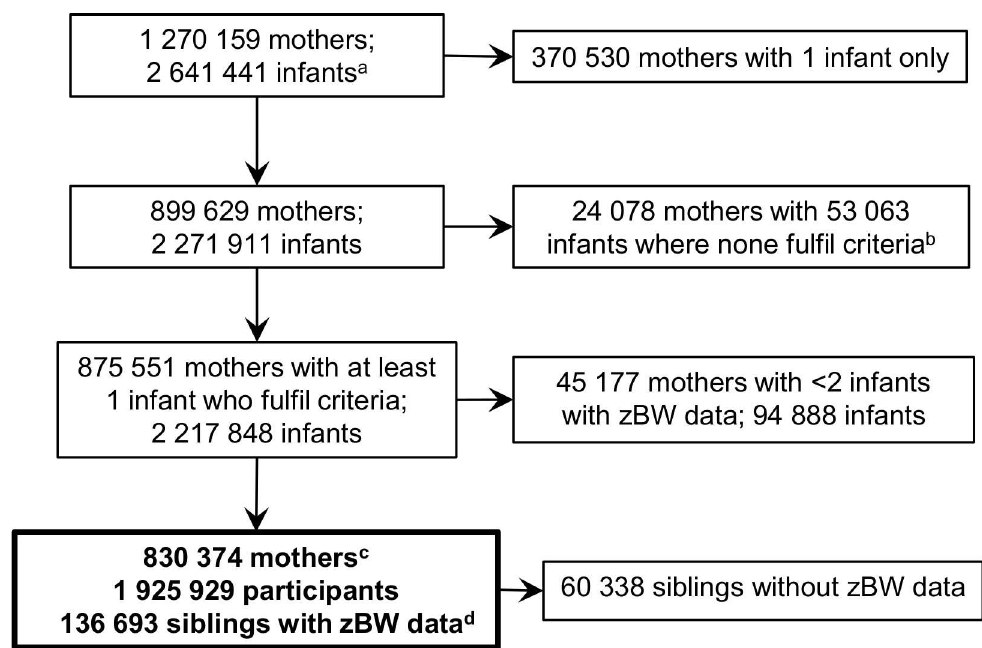
Fig 1. Study population. zBW: z-score birth weight, standardized for year of birth, sex, birth order, gestational week, and plurality. a Not including4445 infants with unidentifiedmothers. b None of mother’s infants fulfilled the criterion of beingsingletonborn at term or post-term, and having zBW data, becausethey were preterm, plural births, missing gestational age, missing birth weight, or combinations of the above. c Mothers who gave birth to a total of 2 122 960 infants (range 2–16, mean 2.56). d Siblingswho did not fulfil participationcriteria becausethey were preterm (68%), plural born (19%), or both (13%), but who contributedwith zBW